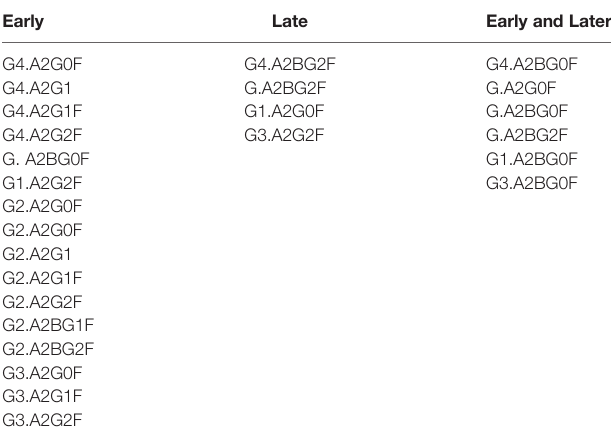
TABLE 2 | Glycans that differentiate either early fi brosis from healthy, late fi brosis from early fi brosis or both.